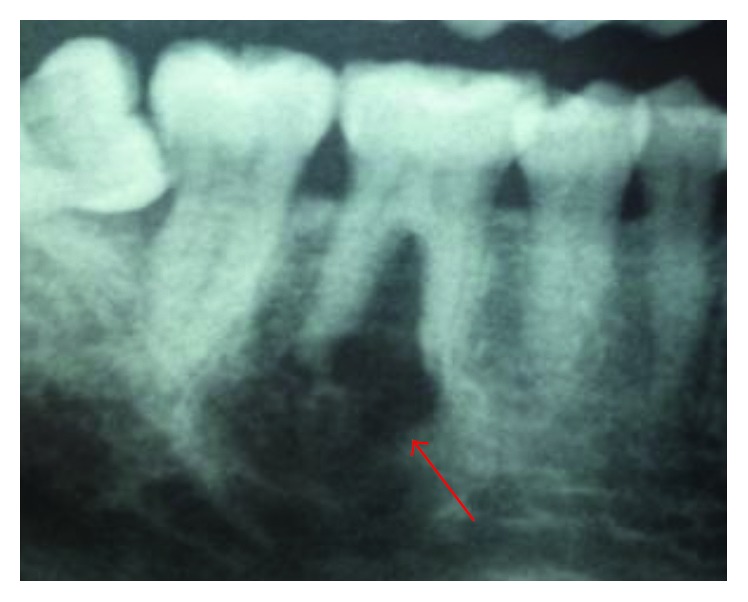
Panoramic radiography showing unilocular radiolucency close to the 46.